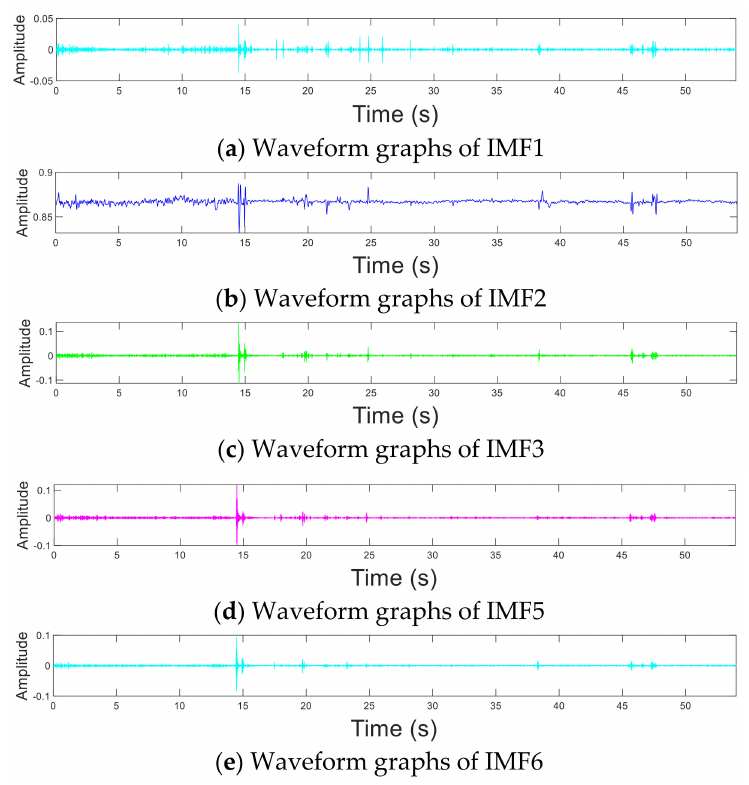
Figure 4. Waveform graphs of IMFs.